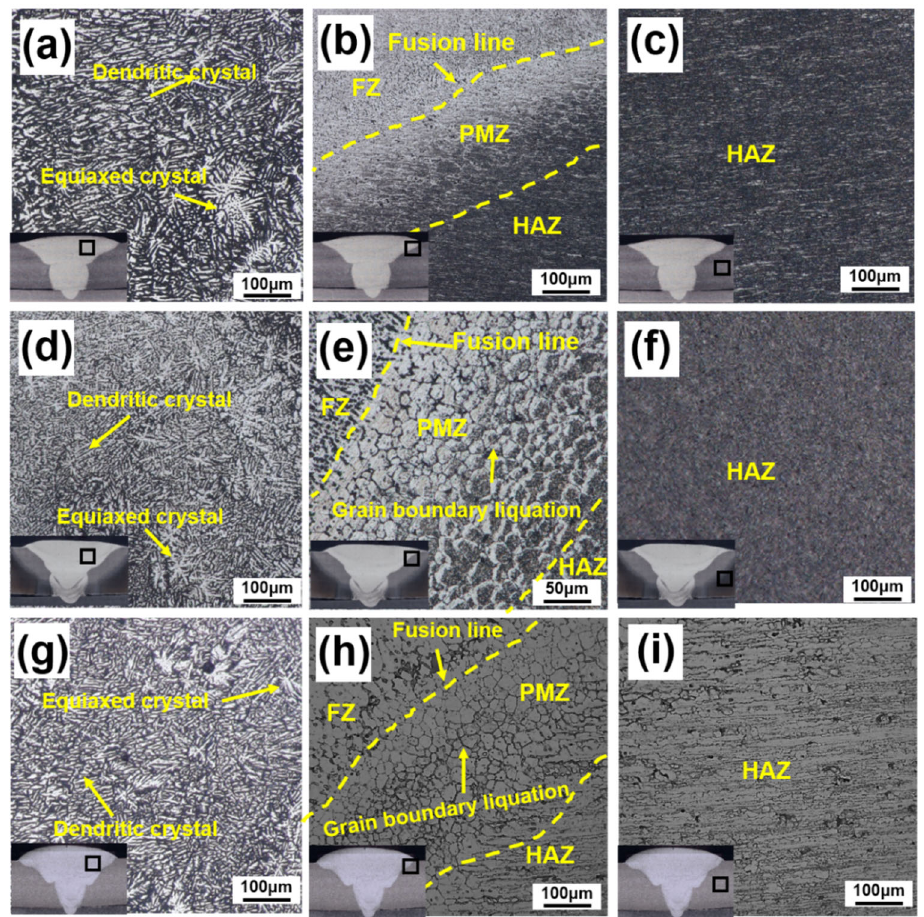
Figure 4. The microstructure of different aluminum alloy welded joints: 5083: ( a ) fusion zone (FZ), ( b ) partially melted zone (PMZ), ( c ) heat-affected zone (HAZ); 6005A: ( d ) FZ, ( e ) PMZ, ( f ) HAZ; 7N01: ( g ) FZ, ( h ) PMZ, ( i ) HAZ.